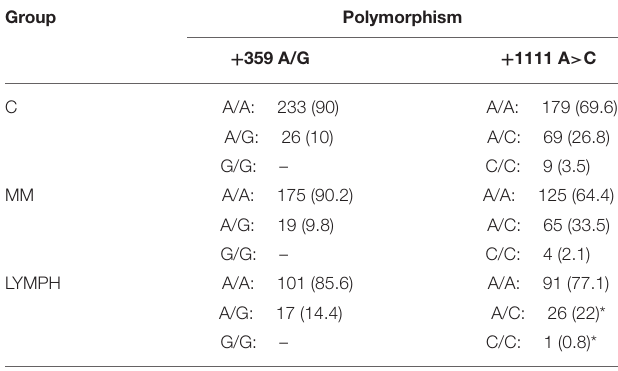
TABLE 4 | Frequency of MASP2 genotypes (corresponding to polymorphisms + 359 A > G and + 1111 A > C SNP) within major groups. Group